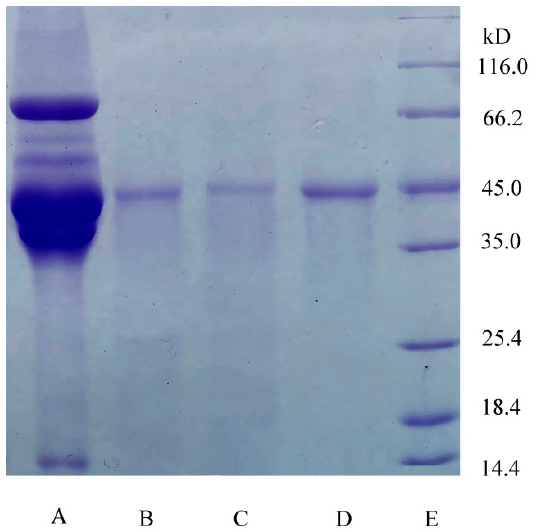
Figure 4. The SDS–PAGE of OVA. Lane A, the salted egg white solution (10 µ g); lane B, sample (20 µ g) separated by ATPF; lane C, sample (10 µ g) separated by ATPF; lane D, OVA standard (10 µ g); lane E, molecular mass standards .